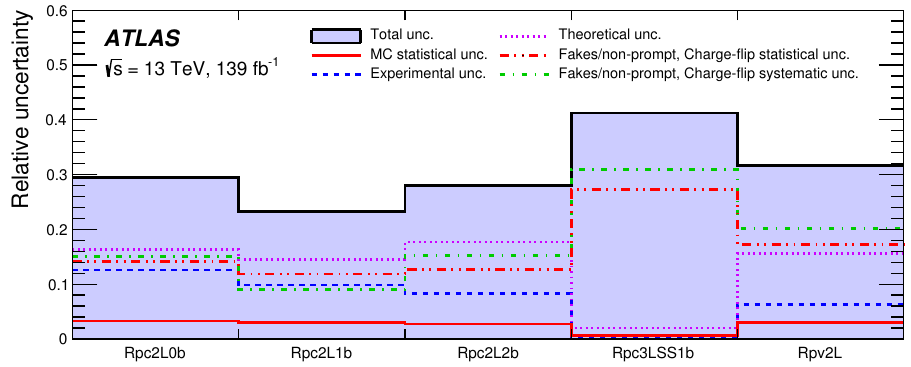
Figure 6. Contributions of di(cid:11)erent categories of uncertainties relative to the expected background yields in the (cid:12)ve SRs. The statistical uncertainties originate from the limited number of preselected or opposite-sign data events used in the matrix method and the charge-(cid:13)ip electron background estimate, respectively, as well as the e(cid:11)ect of limited numbers of simulated events for SM processes.